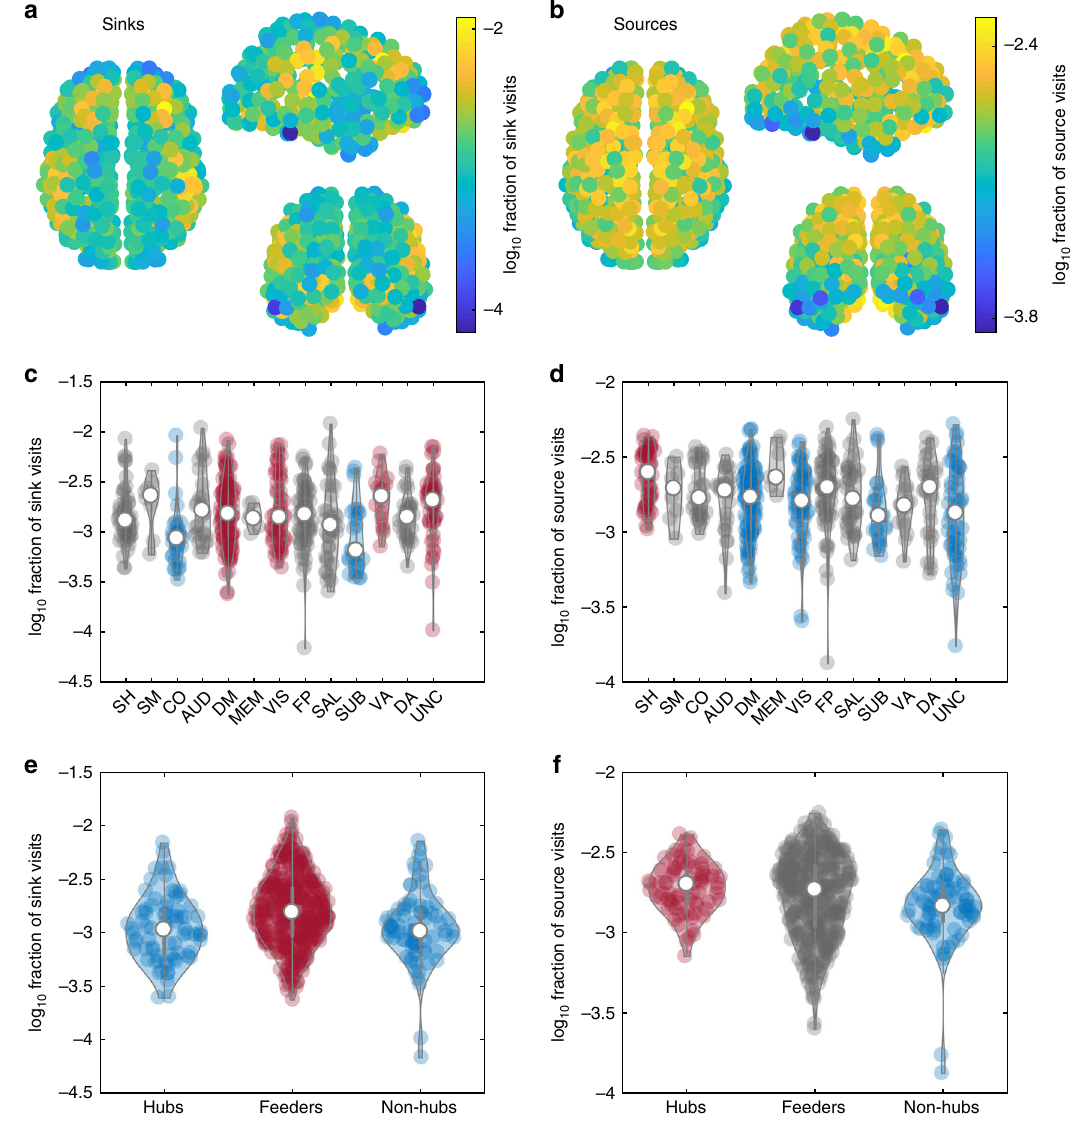
Fig. 7 Sink and source properties. a Spatial distribution of sinks. b Spatial distribution of sources. c Overlap of sinks with functional networks. Blue denotes networks with fewer visits than red and gray denotes no signi fi cant difference from any other group. Networks are labeled as follows: AUD auditory, CO cingulo-opercular, DA dorsal attention, DM default mode, FP fronto-parietal, MEM memory, SAL salience, SH somatomotor hand, SM somatomotor mouth, SUB subcortical, UNC unclassi fi ed, VA ventral attention, VIS visual. d Overlap of sources with functional networks. Colors as per c . e Overlap of sinks with hubs (top 75 nodes by strength), feeders, and non-hubs (bottom 75 nodes by strength). Colors as per c . f Overlap of sources with hubs, feeders, and non-hubs. Colors as per c . White circles in violin plots denote group medians; violins are kernel density estimates. Statistics for c , d are given in Supplementary Table 1 and for e , f in Supplementary Table 2. Source data are provided as a Source Data fi